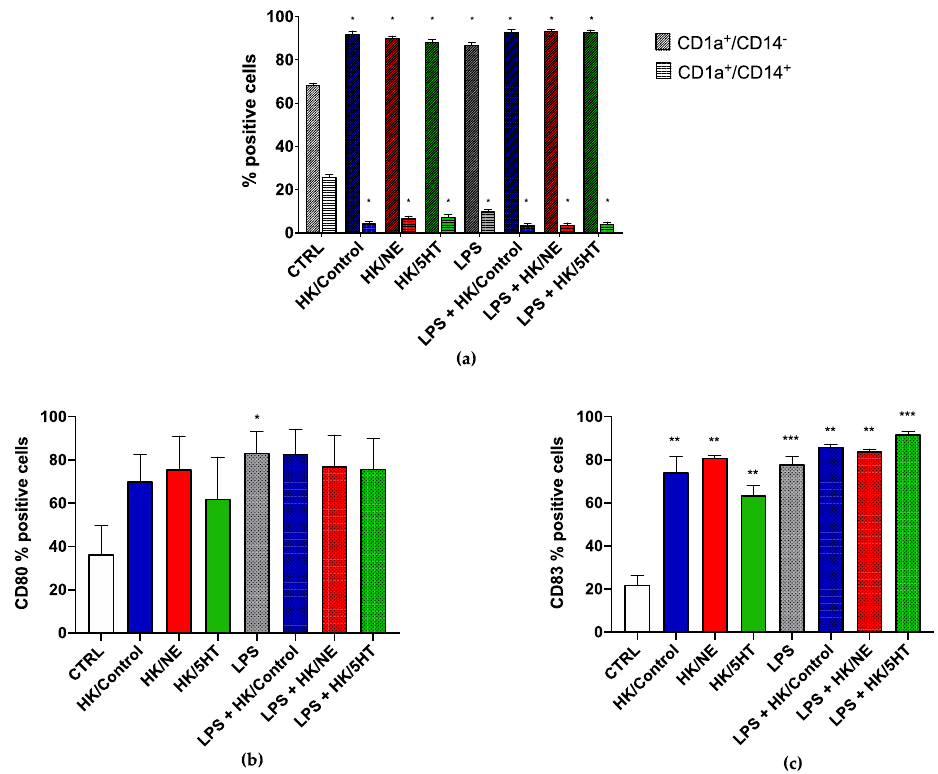
Figure 4. DC differentiation and activation after 40 h incubation with HK/Control (blue), HK/NE (red) and HK/5HT (green) ( a ) % of positive cells ± SEM displaying CD1a + /CD14 − (oblique-line pattern) and CD1a + /CD14 + (straight-line pattern) phenotype as markers of differentiation; ( b ) % of CD80 and ( c ) % of C83 positive cells as markers of maturation (LPS cotreatment is presented in dot pattern). Untreated DCs represent the negative control (CTRL) *** p ≤ 0.001, ** p < 0.01, * p ≤ 0.05 to CTRL.